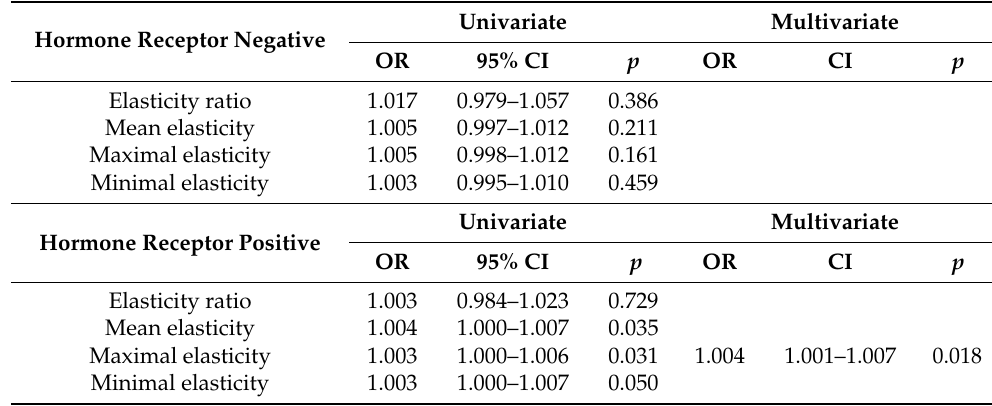
Table A3. Correlation between YAP1 positivity and tumor stiffness based on the hormone recep- tor status.